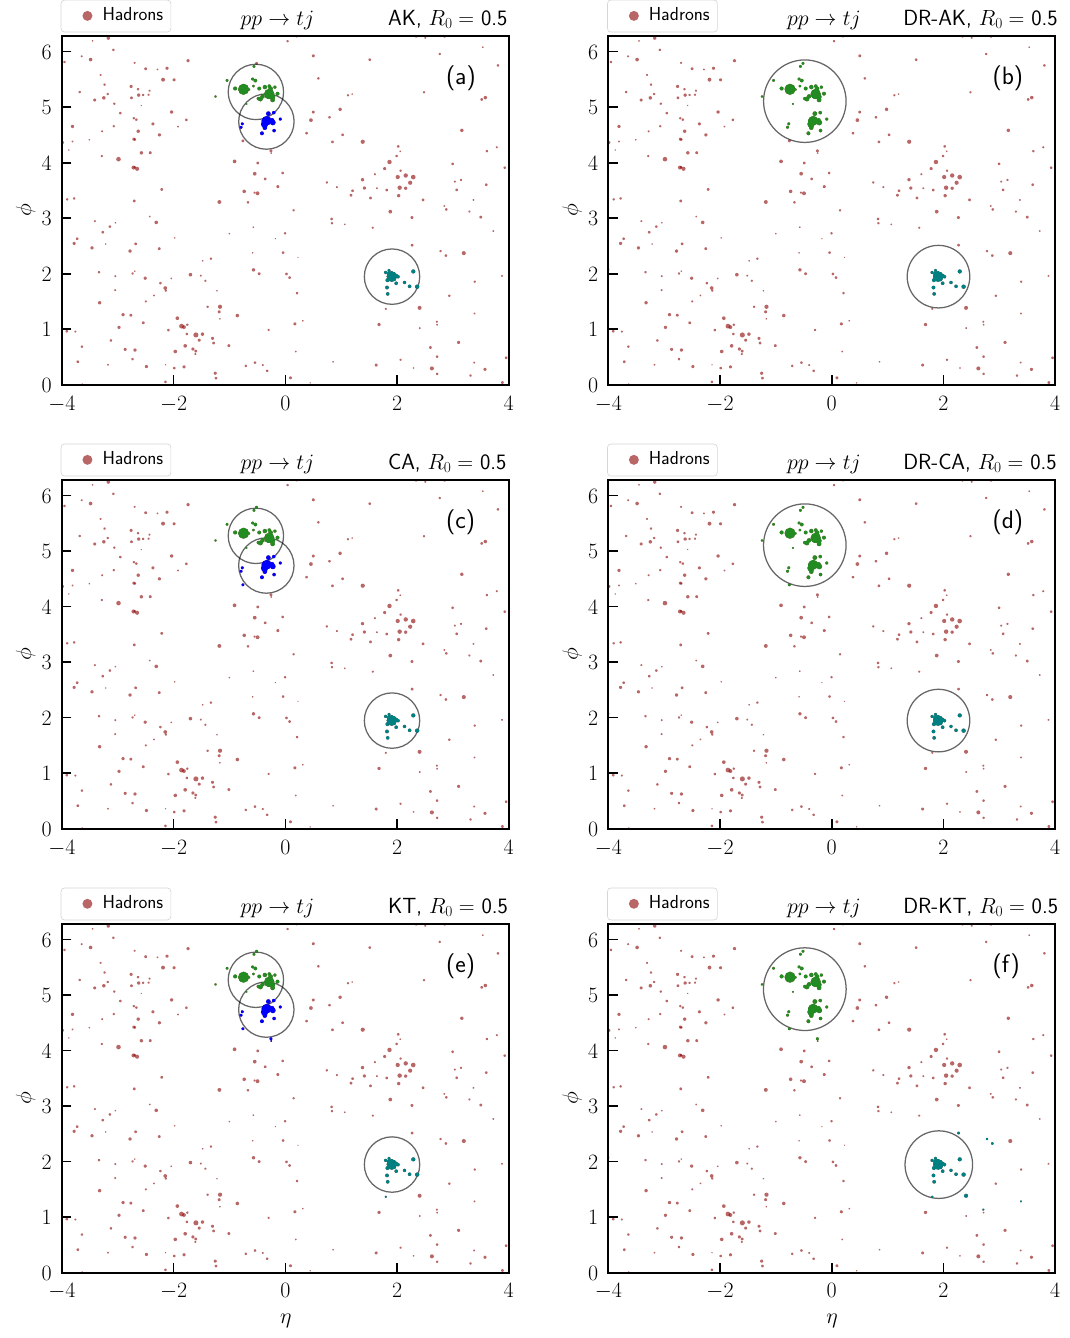
4 − Figure 1 . Positions of final state hadrons and jets in the η - φ plane in an example event for pp → tj process. The red dots represent the final state hadrons and their sizes are kept proportional to of the corresponding hadron. The unfilled circles represent the final radius R coloured dots represent the constituents of the hard ‘narrow’ jets. The green and blue (wherever applicable) dots represent the constituents of the fat top jet. The left panel, from top to bottom, is for (a) AK, (c) CA, and (e) KT algorithms with R represents jets clustered using (b) DR-AK, (d) DR-CA, and (f) DR-KT algorithms, respectively, with R = 0 . 5 0